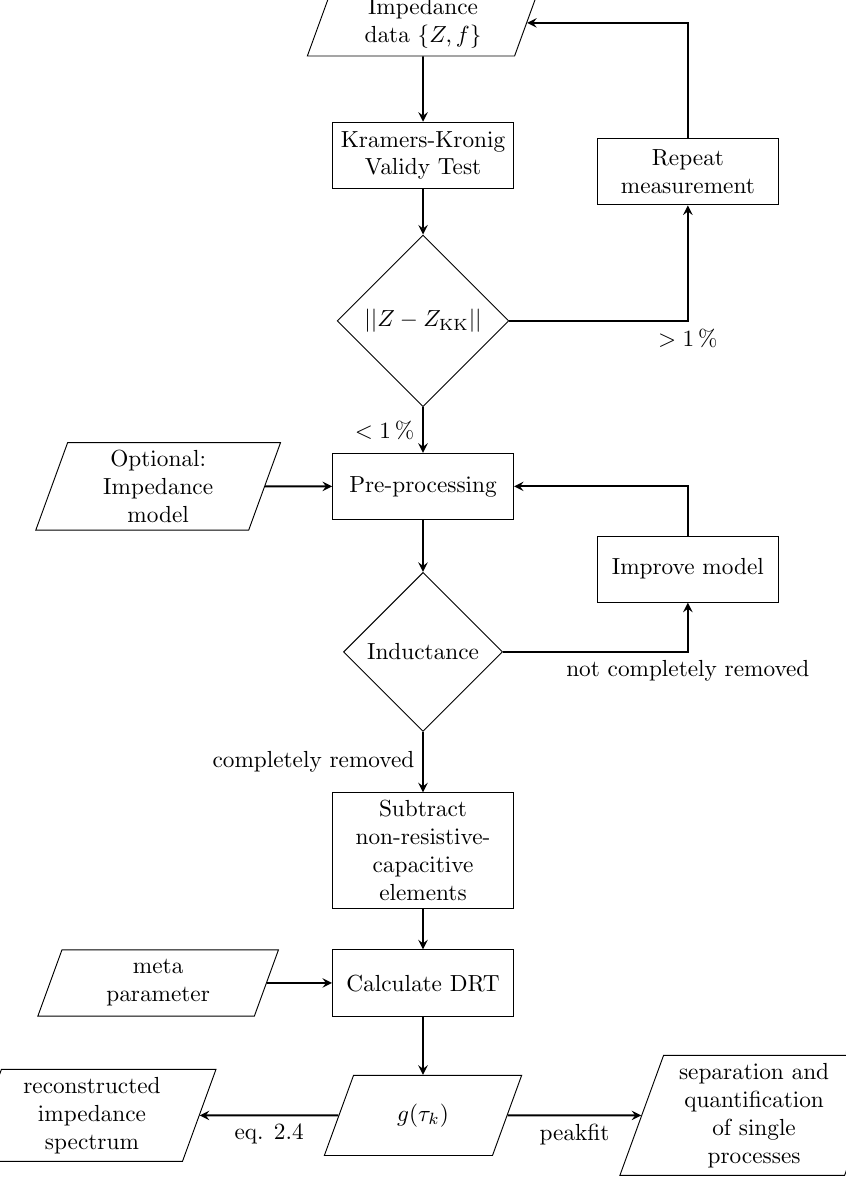
Figure 2. Flowchart of DRT algorithm for handling real, non-ideal measurement